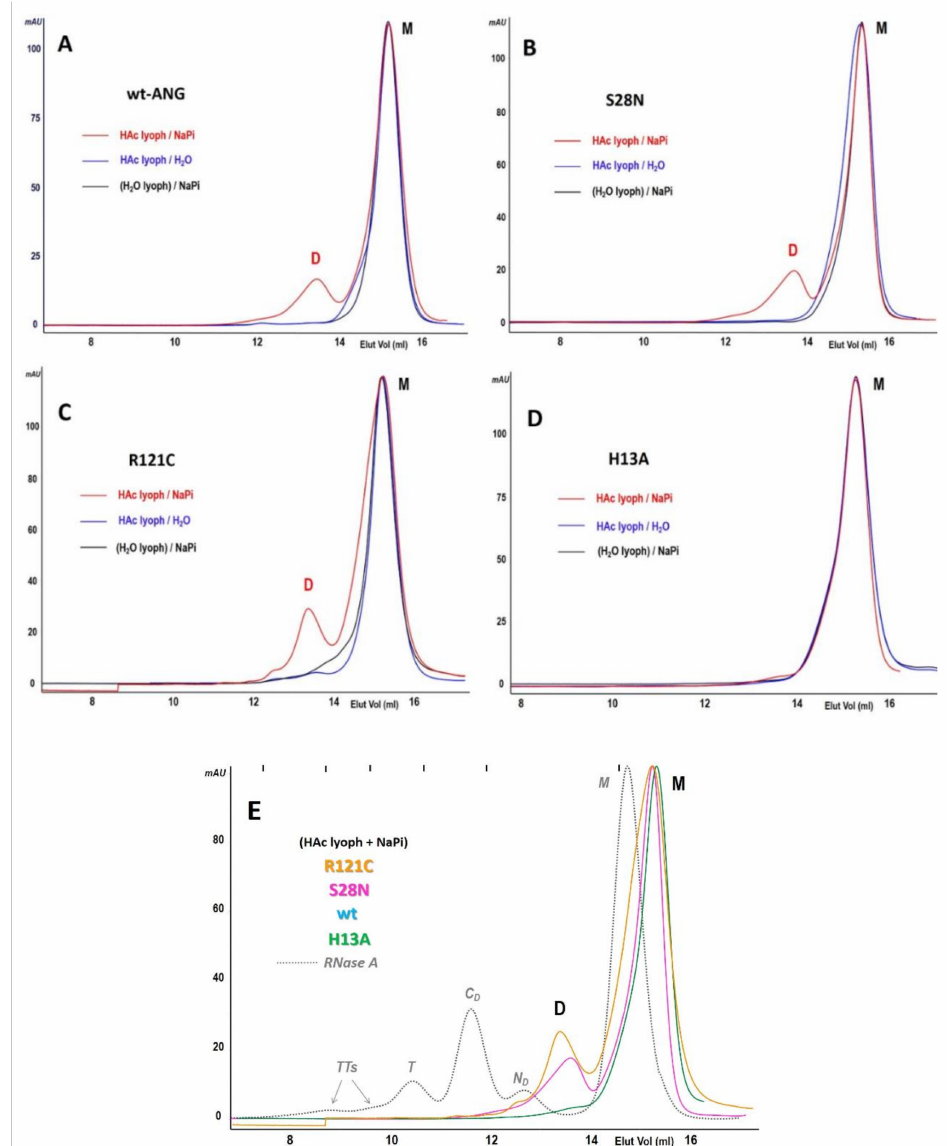
Figure 3. SEC profiles of the dimerization of three ANG variants. ( A – D ): Analysis of ANG variants WT, S28N, R121C, and H13A-ANG after direct solubilization in NaPi, pH 6.7 (black curves), or after lyophilization from 40% HAc and solubilization in H 2 O (blue curves) or in 0.40 M NaPi, pH 6.7 (red curves). Each chromatogram is representative of five (black and blue curves) or eight different tests (red curve). M: monomer, D: dimer.; ( E ): Superposition of the patterns obtained with the three ANG variants after lyophilization from 40% HAc and solubilization in NaPi, compared with the known profile of RNase A. M: ANG monomer, D: ANG dimer, N D or C D : N-swapped or C-swapped RNase A dimer(s) of RNase A, T and TTs : RNase A domain-swapped trimer and tetramers [39]. The positions of the MW standards (Supplementary Figure S2) are indicated with black lines in the upper part of the panel. All A-E patterns were obtained with a Superdex 75 HR 10/300 Increase column equilibrated with 0.40 M NaPi, pH 6.7, with a 0.20–0.25 mL/min flow rate, and normalized to the monomer area with the Unicorn 5.01